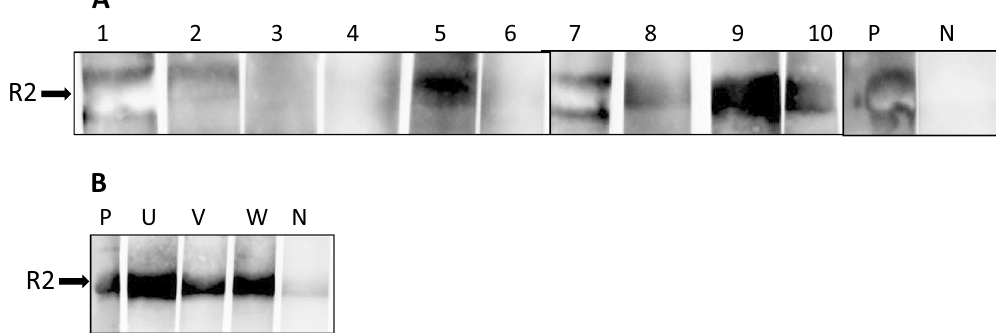
Figure 4. Result of the Western blot analysis using the recombinant R2 fragment of the glycoprotein B of PCMV/PRV. ( A ) nine weeks old animals (number 1 to 10) with positive PCR results in at least one tissue (Fig. 1, Supplementary Table 1) and ( B ) the pigs U, V, and W, 43 or 41 weeks old and which were PCR-negative (Table 2). P, positive control, N, negative control. Serum dilution 1:300, goat anti-pig horse reddish peroxidase was used for detection. Blots were cut prior to hybridization with antibodies during blotting, each stripe was incubated with an individual